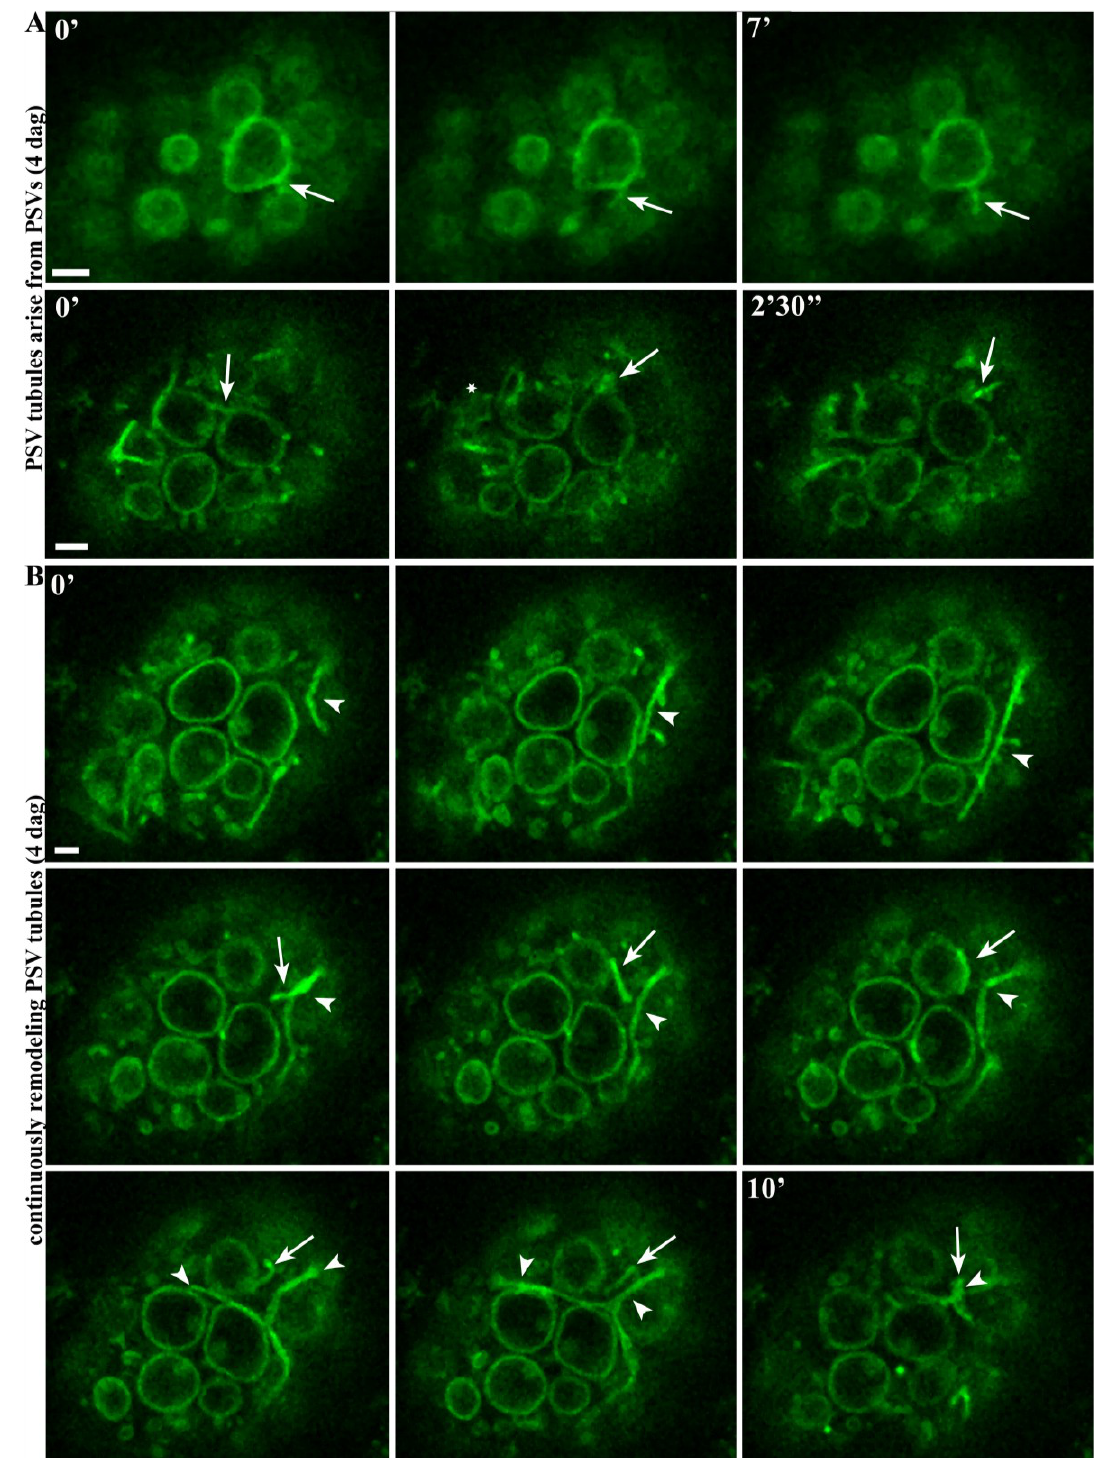
Figure 3. Confocal time series showing tubular structures arising from PSVs and undergoing continuous remodeling. ( A ) Time series of 7 and 2.5 min showing tubular structures arising from PSVs (images captured every 4 s). See the corresponding Movies 5 and 6 for more details; ( B ) Arrowheads and arrows show two different PSV extensions at the beginning of a 10-min time series (images captured every 4 s). See the corresponding Movie 7 for more details. Note the expansion and subsequent retraction of the structure, allowing the PSV extension to contact another PSV before release (arrow). Scale bar = 2